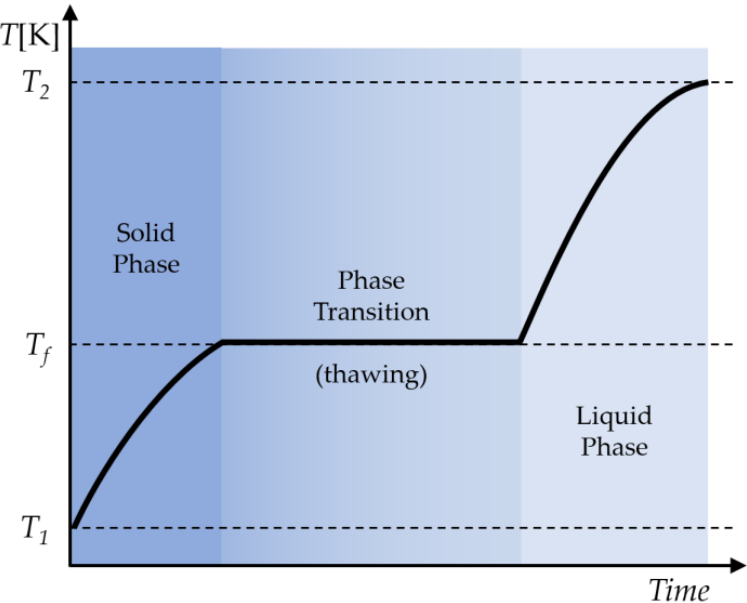
Figure 5. Temperature evolution of a PCM, from solid to liquid, including sensible heating outside the phase transition region.